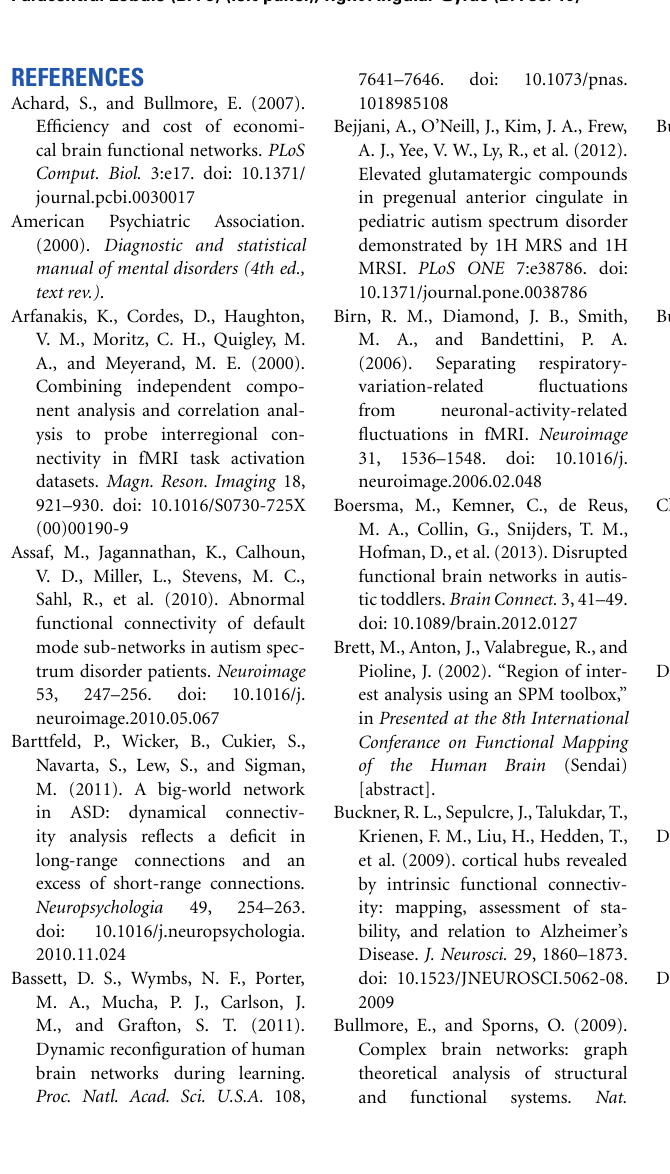
FIGURE S1 | Group differences in seed-based connectivity maps in resting and task states, for three clusters showing Group × Task interaction: left orbital frontal gyrus (BA 11) (left panel), left middle frontal gyrus (BA 10) (middle panel) and left premotor (BA 6/9) (right panel). Region numbers 1–3 on the left corner in the brain image correspond to the region number in Figure 1 . FIGURE S2 | Group differences in seed-based connectivity maps in resting and task states, for three clusters showing Group × Task interaction: left premotor (BA 8) (left panel), left premotor (BA 6) (middle panel) and SMA (BA 32/8) (right panel). Region numbers 4–6 on the left corner in the brain image correspond to the region number in Figure 1 . FIGURE S3 | Group differences in seed-based connectivity maps in resting and task states, for three clusters showing Group × Task interaction: Paracentral Lobule (BA 6) (left panel), right Angular Gyrus (BA 39/40)